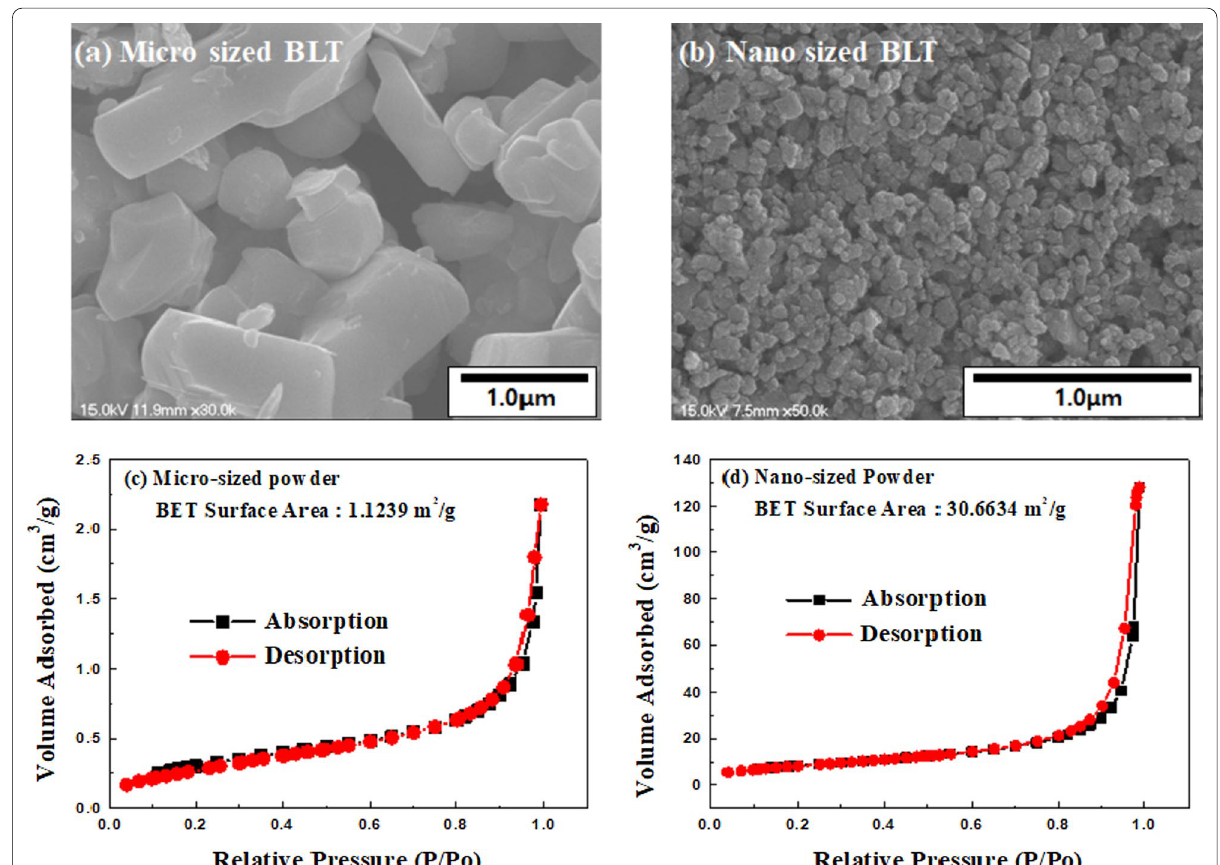
Fig. 2 FE-SEM images and Nitrogen adsorption–desorption isotherm and pore size distribution of BLT ceramics prepared and treated by high energy ball milling for 3 h; a and c micro-sized, and b and d nano-sized